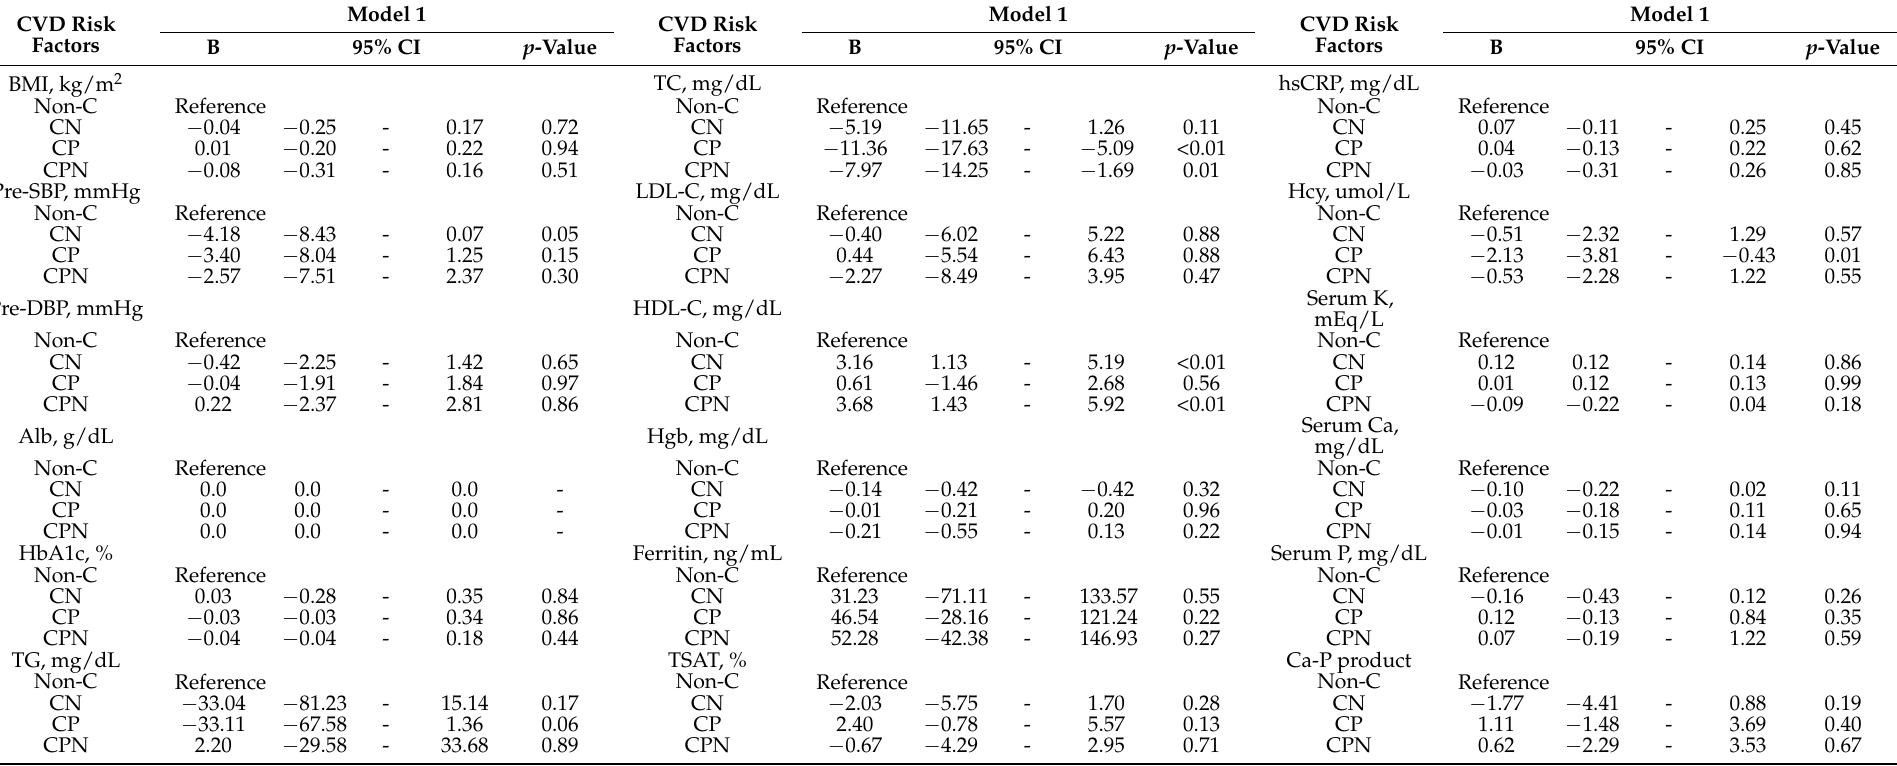
Table 4. Comparison of the changes in CVD risk factors in different education models during the experiment, with non-C as the reference